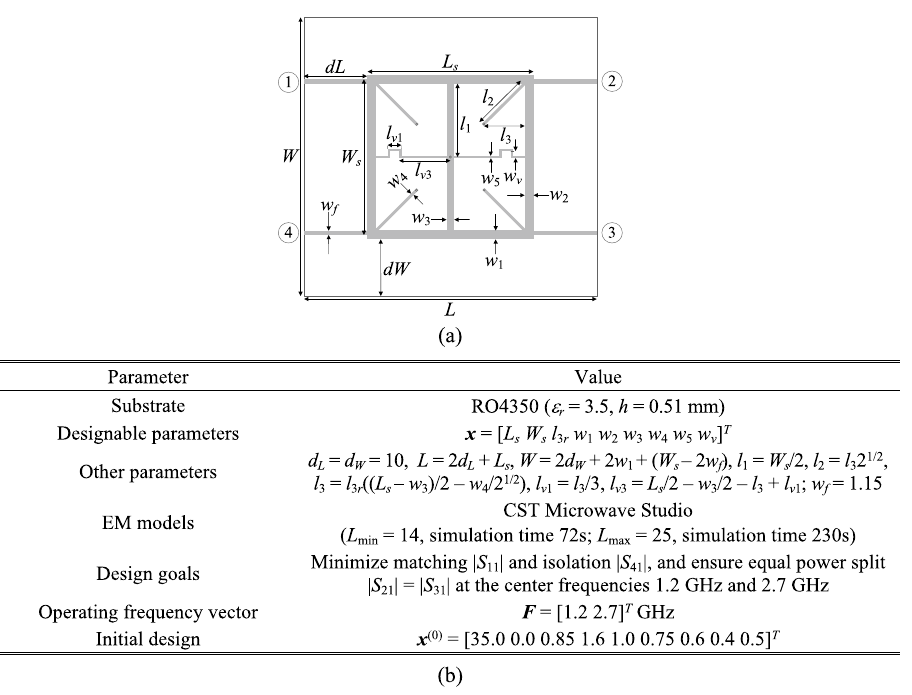
Figure 9. Dual-band branch-line coupler (Circuit II): ( a ) geometry 82 ; ( b ) main parameters and design objectives.